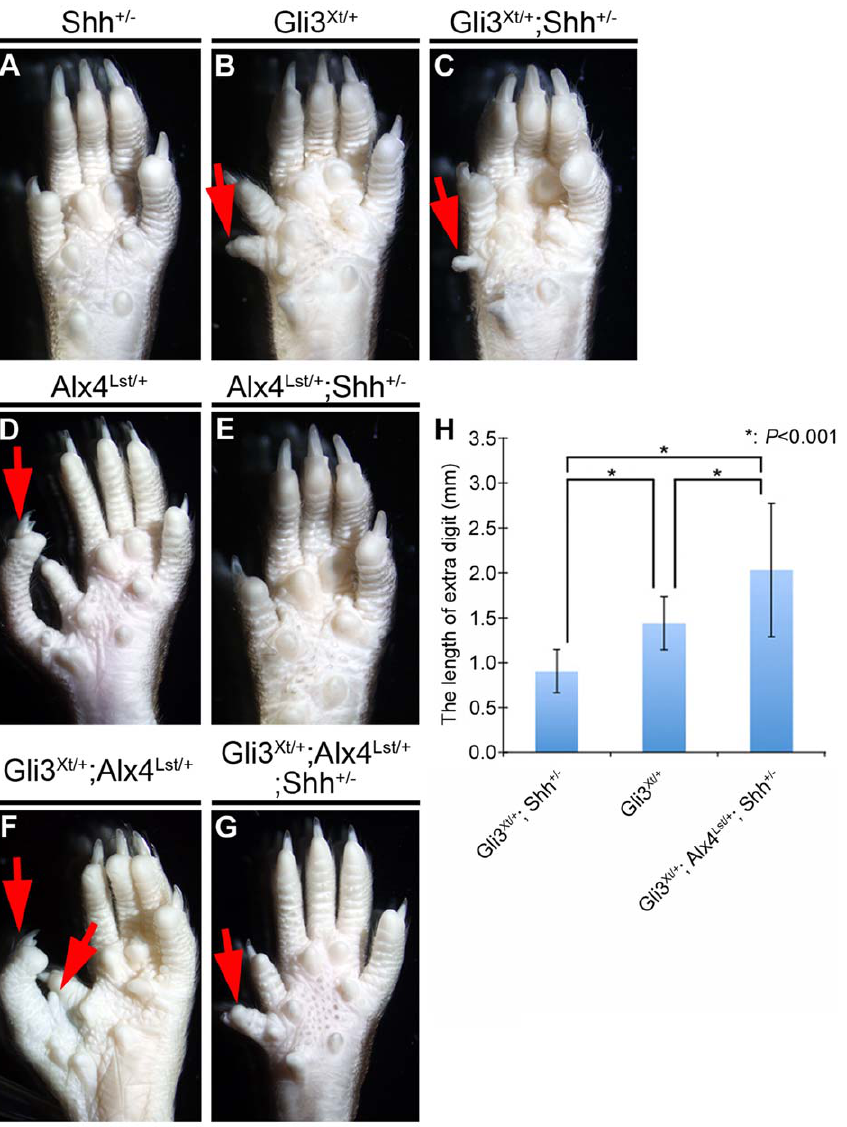
Figure 2. The digit phenotypes of Shh , Alx4 and Gli3 heterozygotes. Shh heterozygous mutants ( Shh + / 2 ) showed a normal number of digits ( A ). Both Gli3 and Alx4 heterozygotes ( Gli3 Xt/ + or Alx4 Lst/ + ) displayed polydactyly phenotypes in the hind limbs ( B, D ). Polydactylies were partially restored ( C ) or fully restored ( E ) by the addition of a Shh heterozygous mutation in Gli3 Xt/ + or Alx4 Lst/ + heterozygotes. The Gli3 Xt/ + ; Alx4 Lst/ + double heterozygotes displayed polydactyly with more than two extra digits ( F ). Polydactylies in the Gli3 Xt/ + ; Alx4 Lst/ + double heterozygotes were partially restored by the additional introduction of a Shh heterozygous mutation ( Gli3 Xt/ + ; Alx4 Lst/ + ; Shh + / 2 ) ( G ). Red arrows indicate extra digits. The length of the extra digit was measured for each genetic combination ( H ). An asterisk indicates statistical significance based on the comparison of each mutant by Student’s t -test. The results are presented as the means 6 SD. * P , 0.001.